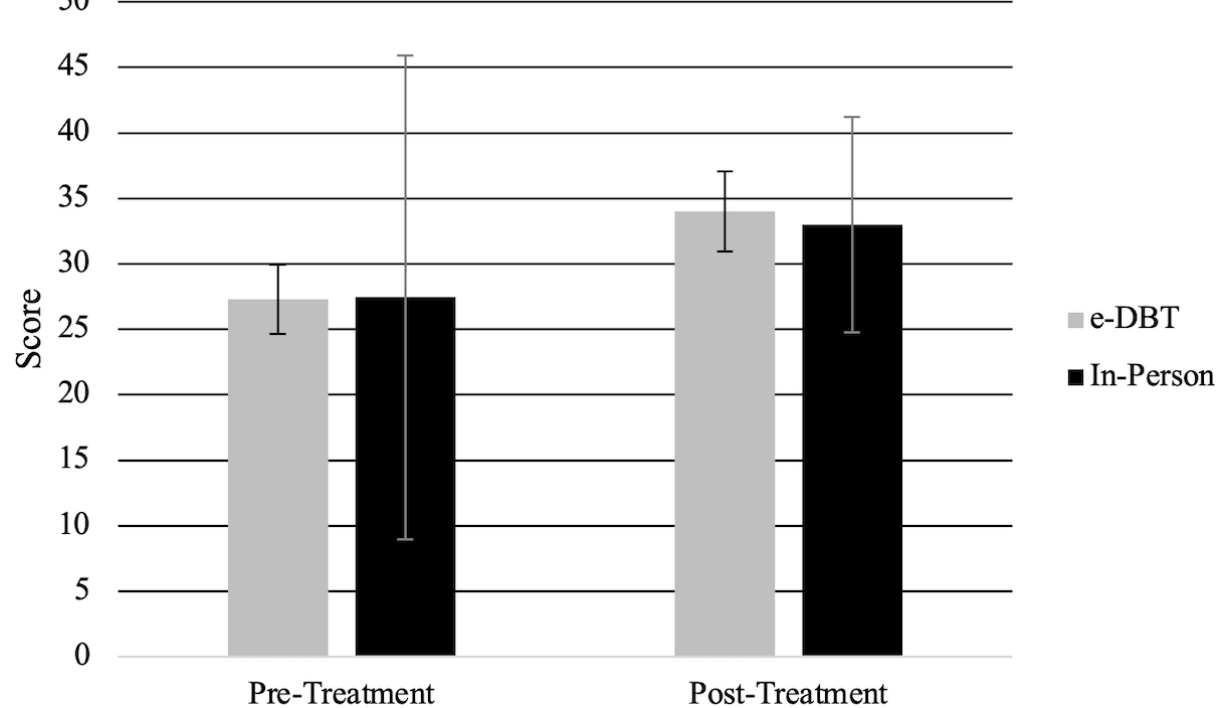
Figure 3. Self-Assessment Questionnaire scores at baseline (pre) and 15 weeks (post). e-DBT: electronically delivered dialectical behavioral